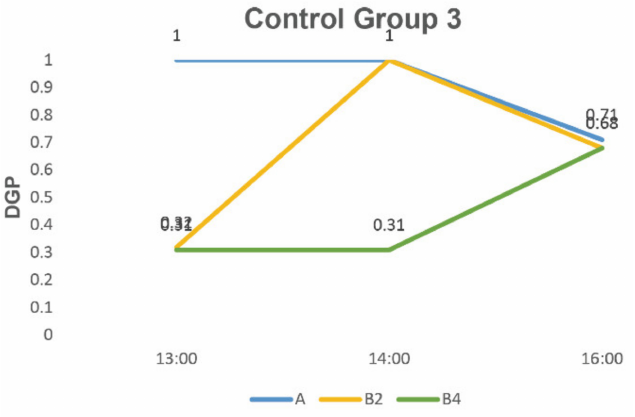
Figure 14. Comparation results of control group 2.